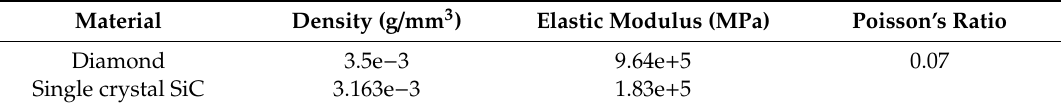
Table 2. Physical and mechanical properties of diamond and single crystal SiC.